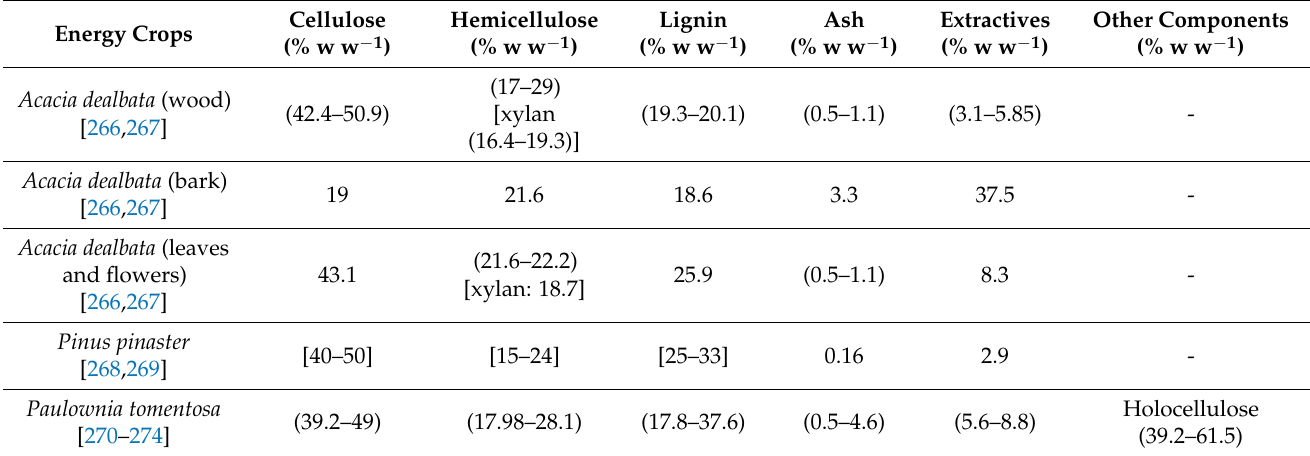
Table 2. Chemical composition of forest